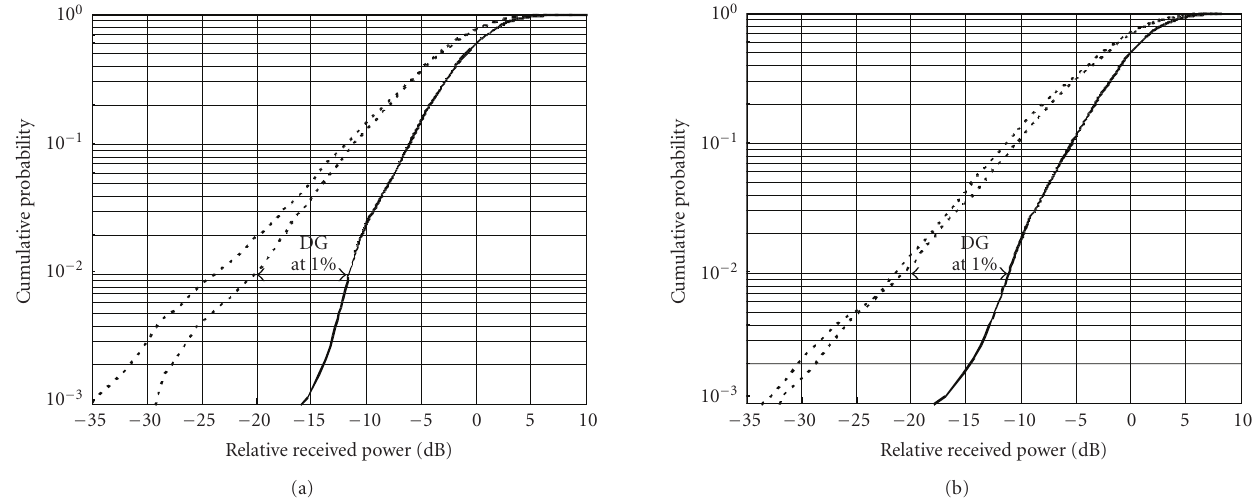
Figure 9: Processed cumulative probability of the two-antenna systems with the smooth function of Matlab; (a) initial structure, (b) neu- tralized